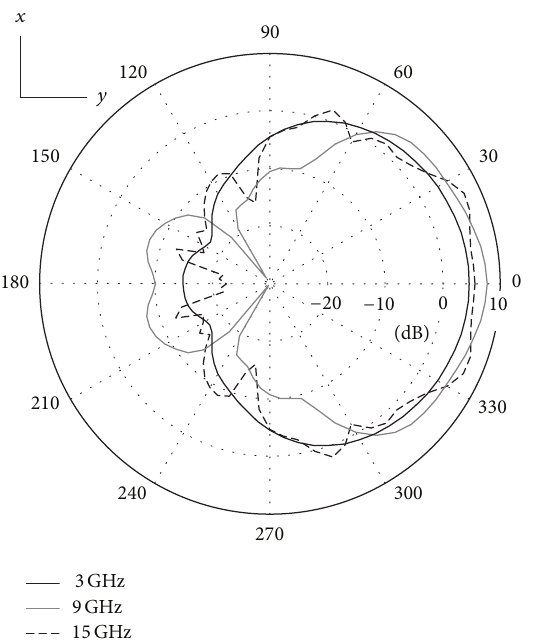
Figure 17: Radiation pattern of a semiplanar conical antenna with elliptical aperture and reflector in the xy plane.